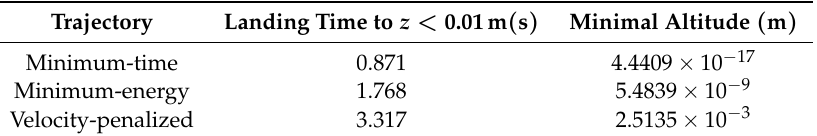
Table 1. Comparison of trajectories.